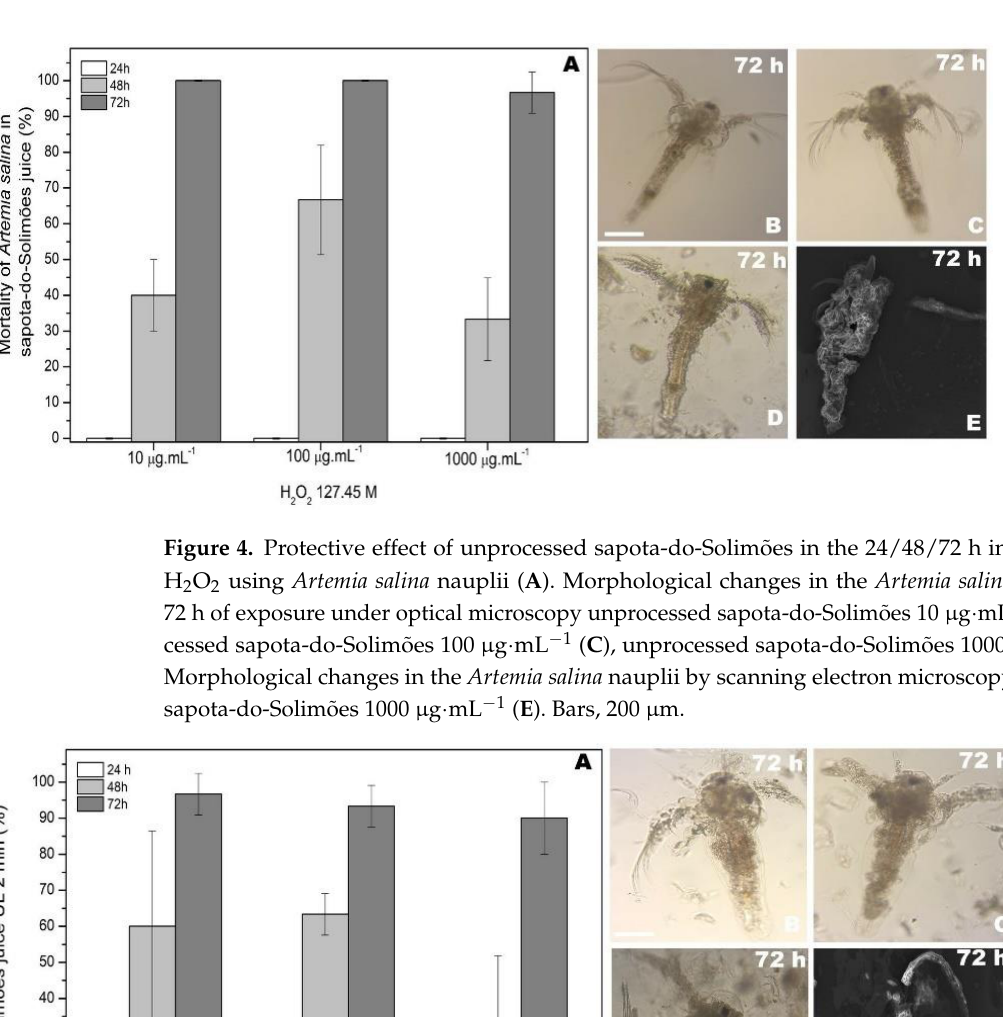
9 of 18 Figure 3. Control samples during protective effect in the 24/48/72 h interval against H 2 O 2 in Artemia salina nauplii ( A ). Morphological changes in the Artemia salina nauplii after 72 h of exposure under optical microscopy seawater ( B ), K 2 Cr 2 O 7 ( C ), and H 2 O 2 ( D ). Morphological changes in the Artemia salina nauplii by scanning electron microscopy seawater ( E ), K 2 Cr 2 O 7 ( F ), and H 2 O 2 ( G ). Bars, 200 µm. Figure 4A shows that the unprocessed sapota-do-Solimões juice decreased the toxicity induced by H 2 O 2 (127.45 M) to A. salina mortality by 40% (10 µg·mL −1 ) and 35% (1000 µg·mL −1 ) compared with the (Figure 3A) after 48 h of exposure. After 72 h, none of the A. salina survived. The improvement of A. salina survival can be explained by different compounds present in the juice, including antioxidant compounds that mitigated the action of free radicals [15]. For instance, short-chain fatty acids increased the survival of A. salina infected by the pathogenic Vibrio campbellii strain [41]. After 72 h of the protective effect assay (Figure 4B – D), the A. salina presented damage in the entire body with a deterioration aspect in the three different concentrations (10 – 1000 µg·mL −1 ). Figure 4E shows the complete degradation (wrinkled body, and loss of body parts) caused by H